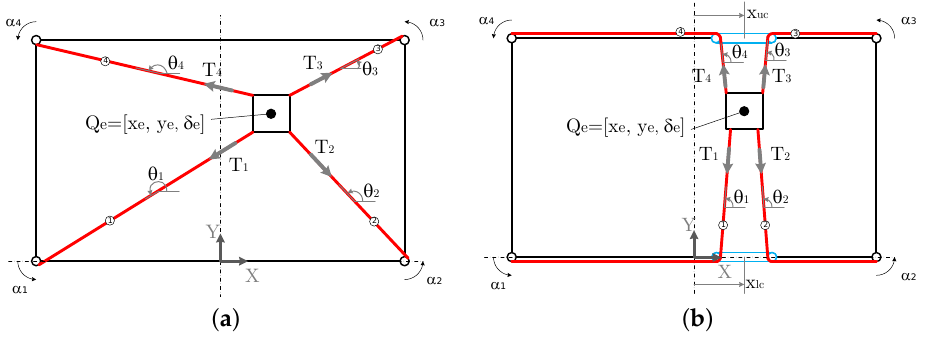
Figure 2. Scheme for nomenclature. ( a ) Conventional scheme; ( b ) new